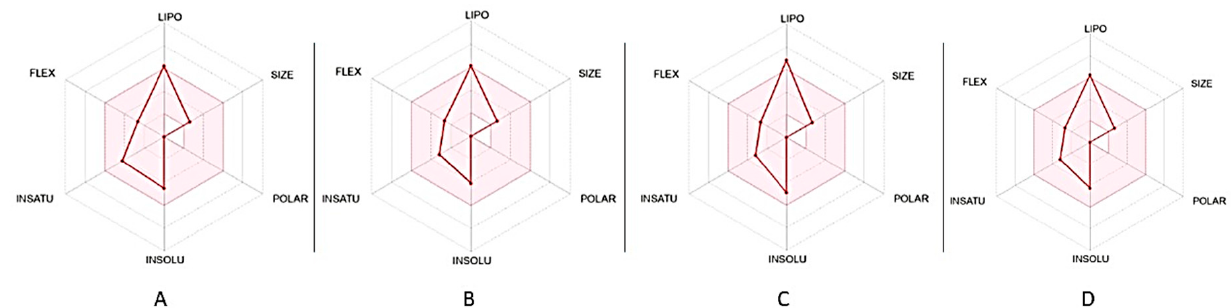
hybridization not less than 0.25, and flexibility: no more than nine rotatable bonds).